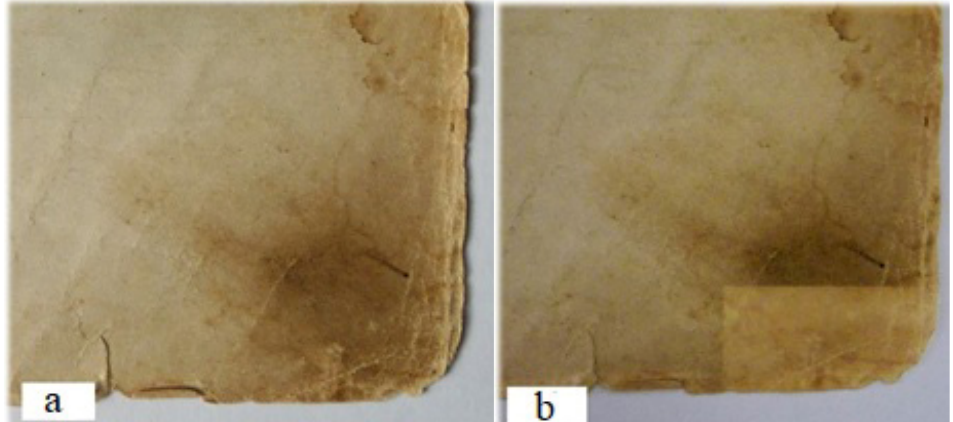
Figure 4. Flyleaf of a Russian typographic book (the beginning of the XIX century) with characteristic surface contamination: ( a )—before laser cleaning; ( b )—after laser treatment (light yellow rectangle in the lower right part of the sheet).